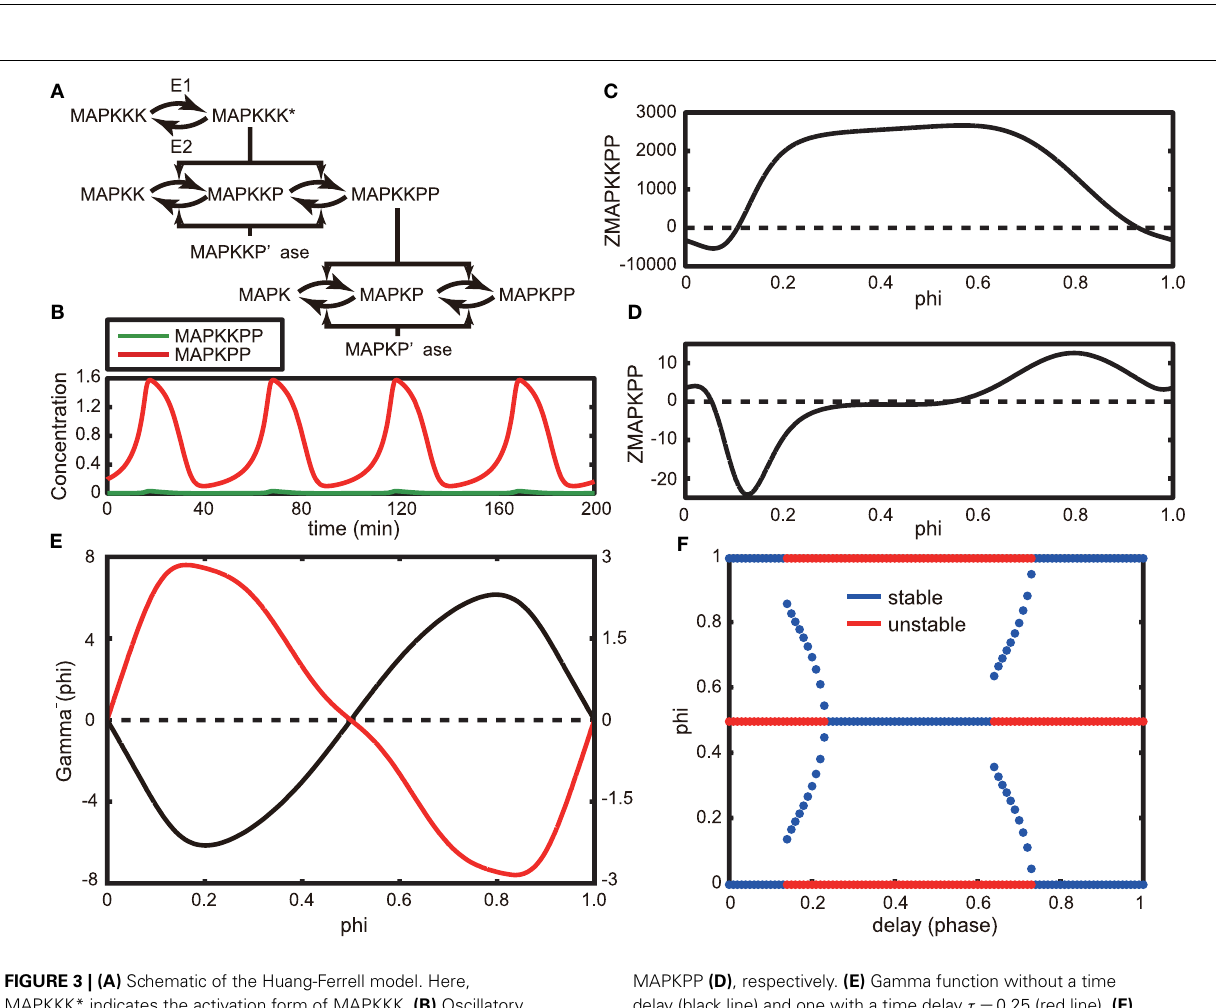
FIGURE 2 | (A) Schematic of a pair of the identical oscillators of Model A. Here, we assume weak interactions between each Mp and Kin. (B) Gamma function of the coupled system shown in (A) , in which we adopt g Mp = 1 and